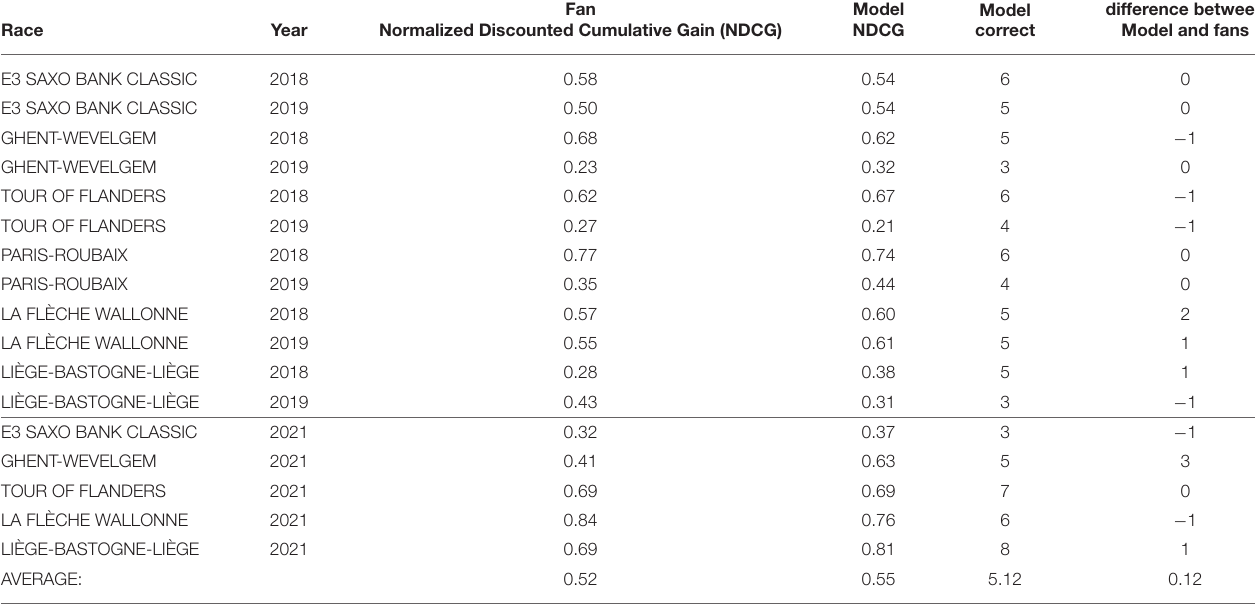
TABLE 3 | Fan prediction compared to the Machine Learning